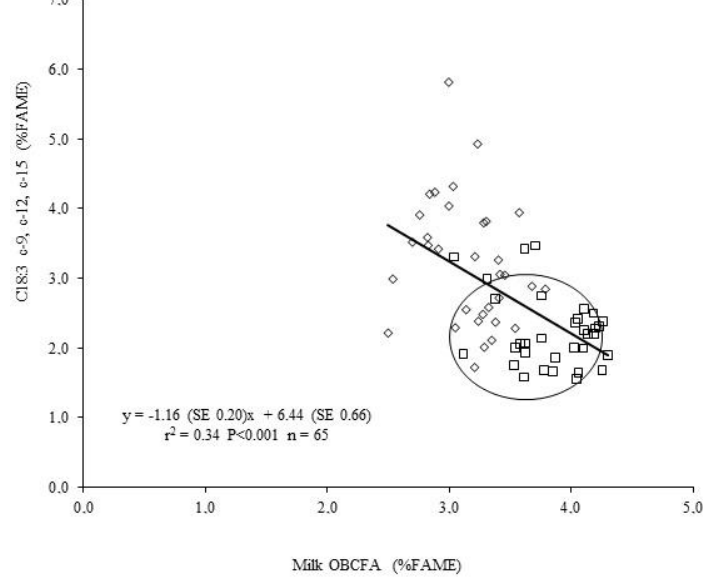
Figure 6. Relationship between odd- and branced-chain fatty acid (OBCFA) and C18:3 c-9, c-12 c-15 content in milk of sheep grazing sulla either receiving or not receiving an antitannic supplementation (each point is an individual value: ◊ = sulla with tannin effect; □ = sulla without tannin effect) [36]. Usupplemented dairy sheep grazing a mixed pasture ( Trifolium repens , Lolium perenne , Medicago sativa , Festuca arundinacea and Trifolium fragiferum ) had a higher content in milk of MUFA, PUFA,